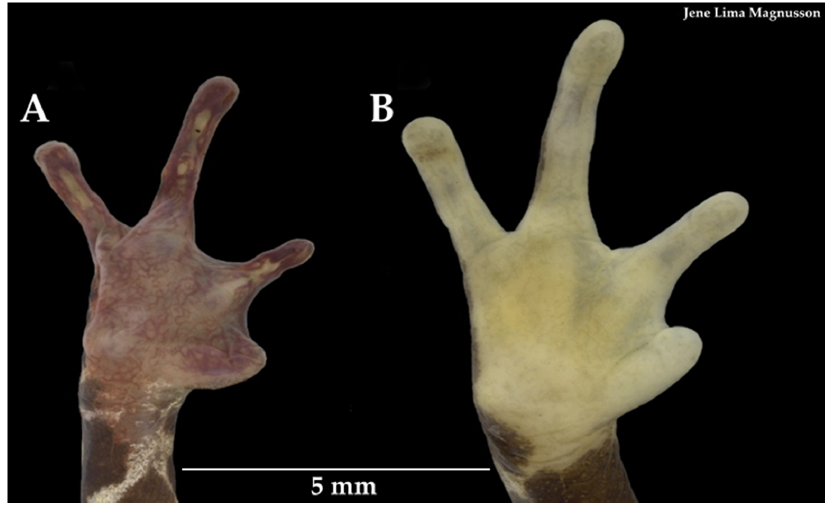
Figure 4. Ventral view of the hand of Atelopus manauensis sp. nov. in preservative: ( A ) holotype; ( B ) Figure 4. Ventralviewofthehandof Atelopusmanauensis sp. nov. Inpreservative: ( A )holotype; ( B )allotype. Diversity 2020 , 12 , x FOR PEER REVIEW allotype.